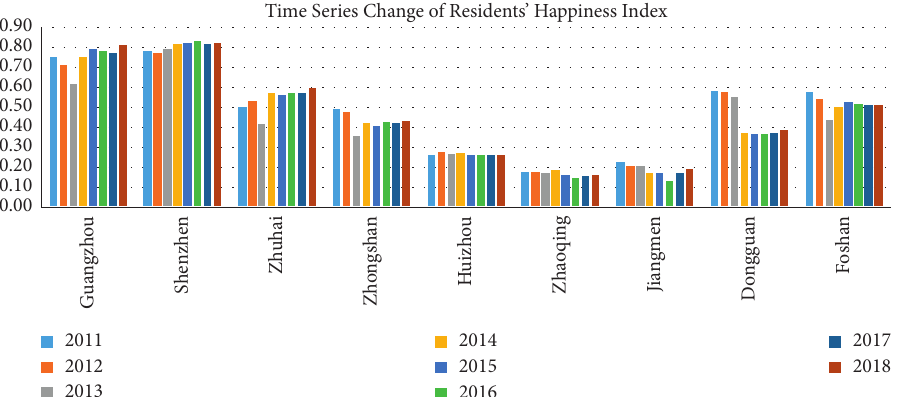
Figure 4: Time series changes of the comprehensive happiness index of residents in the Pearl River